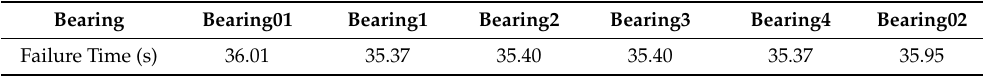
Table 3. Failure time of the